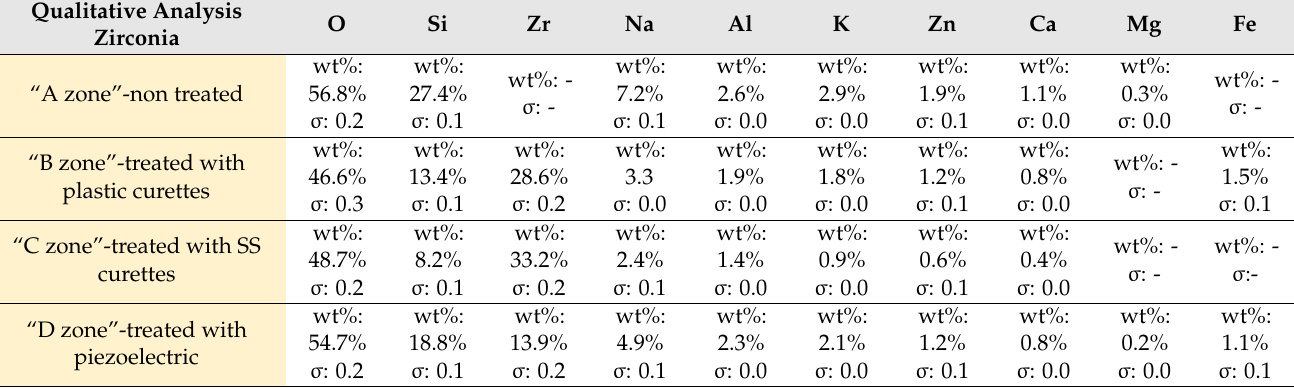
Figure 5. SEM scans of CAD-CAM Disilicate “A zone” ( a , b ), “B zone” ( c , d ); “C zone” ( e , f ) and “D zone” ( g , h ). Table 1. Qualitative microanalyse of CAD-CAM